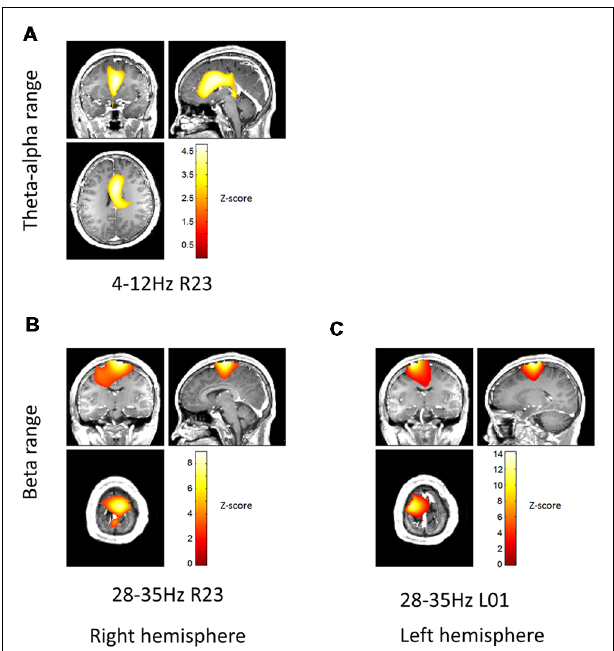
FIGURE 2 | Beamformer localization of significant coherent clusters. The frequency bands for each local field potentials (LFPs) channel were determined based on sensor-level test (see “Materials and Methods” section). Dynamic Imaging of Coherent Sources (DICS) coherence beamformer (Gross et al., 2001) was used for source analysis. For visualization purposes, the beamformer images were converted to Z -score across voxels, thresholded above 2.5 and overlaid on the patient’s pre-operative T1 structural. Panel (A) shows localization of theta-alpha (4–12 Hz) coherence with the right STN. Panels (B,C) show localization of high beta (28–35 Hz) coherence with the right and left STN, respectively.